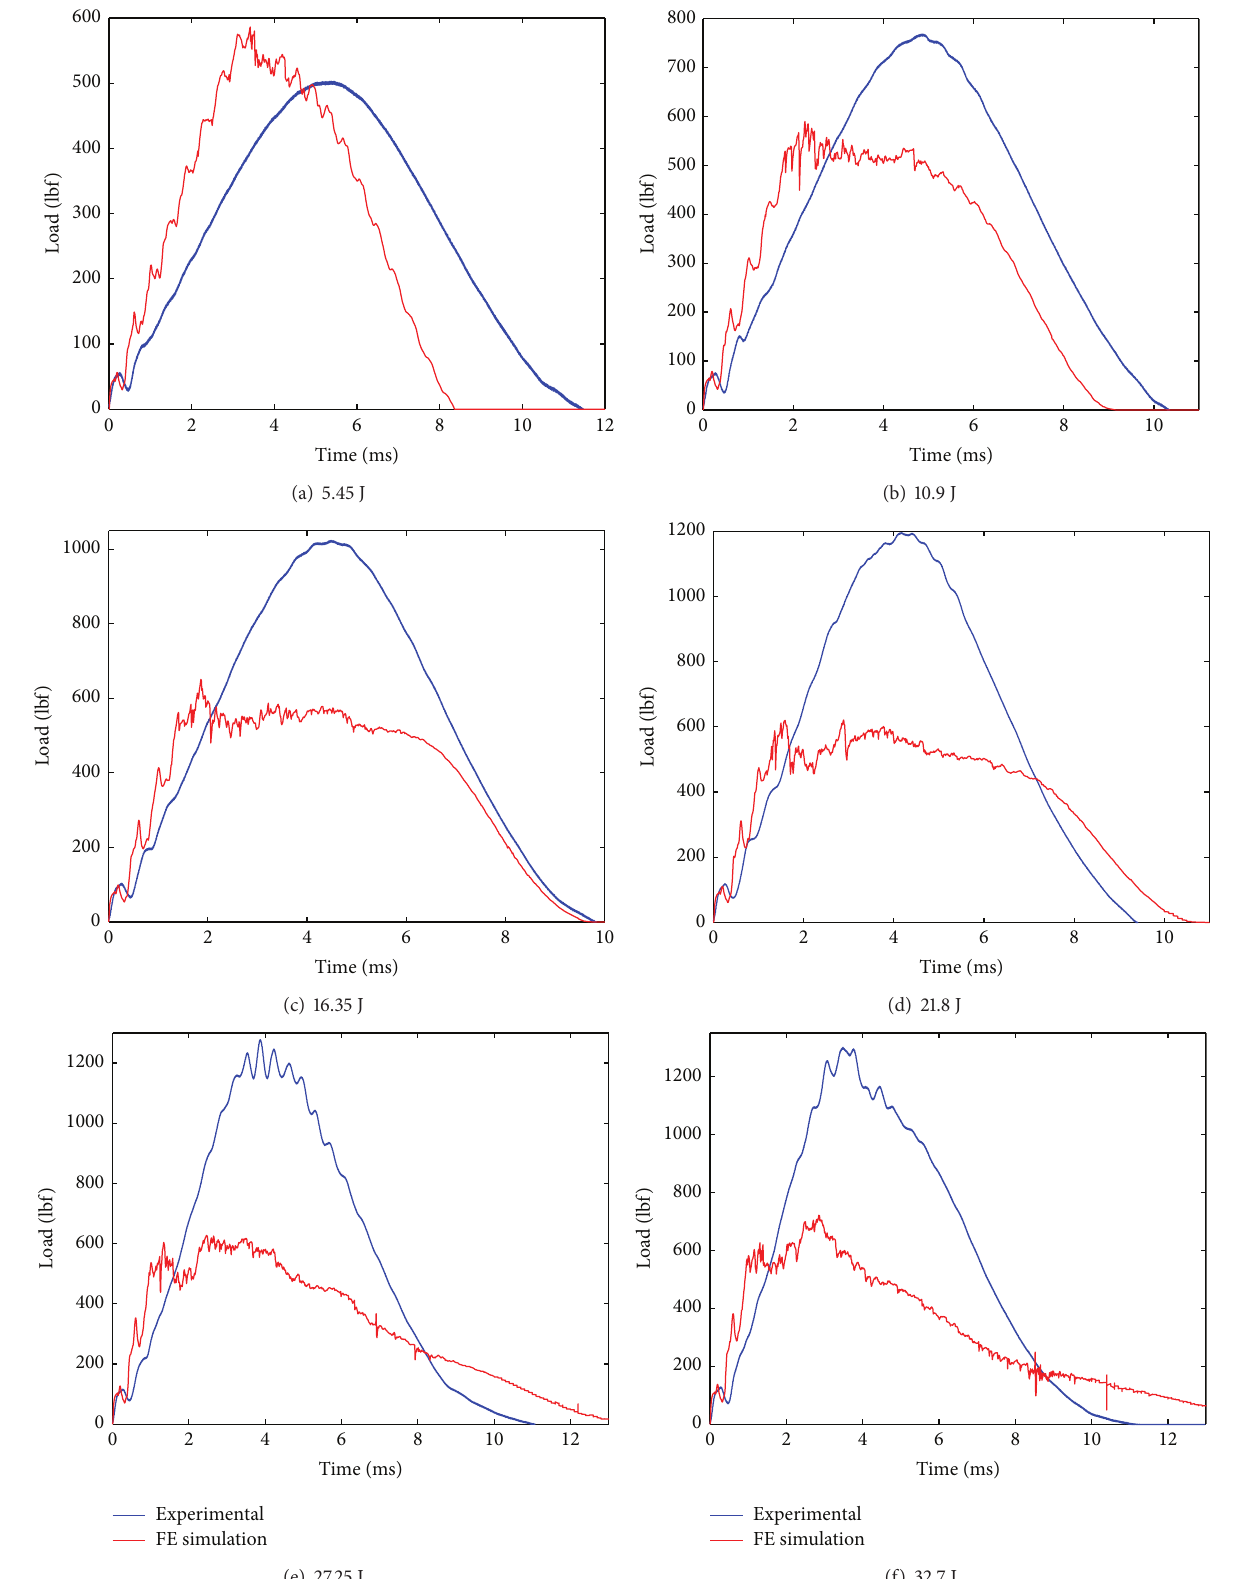
Figure 11: Impact load versus time plots for Hybrid262/Epoxy laminates at six impact energy